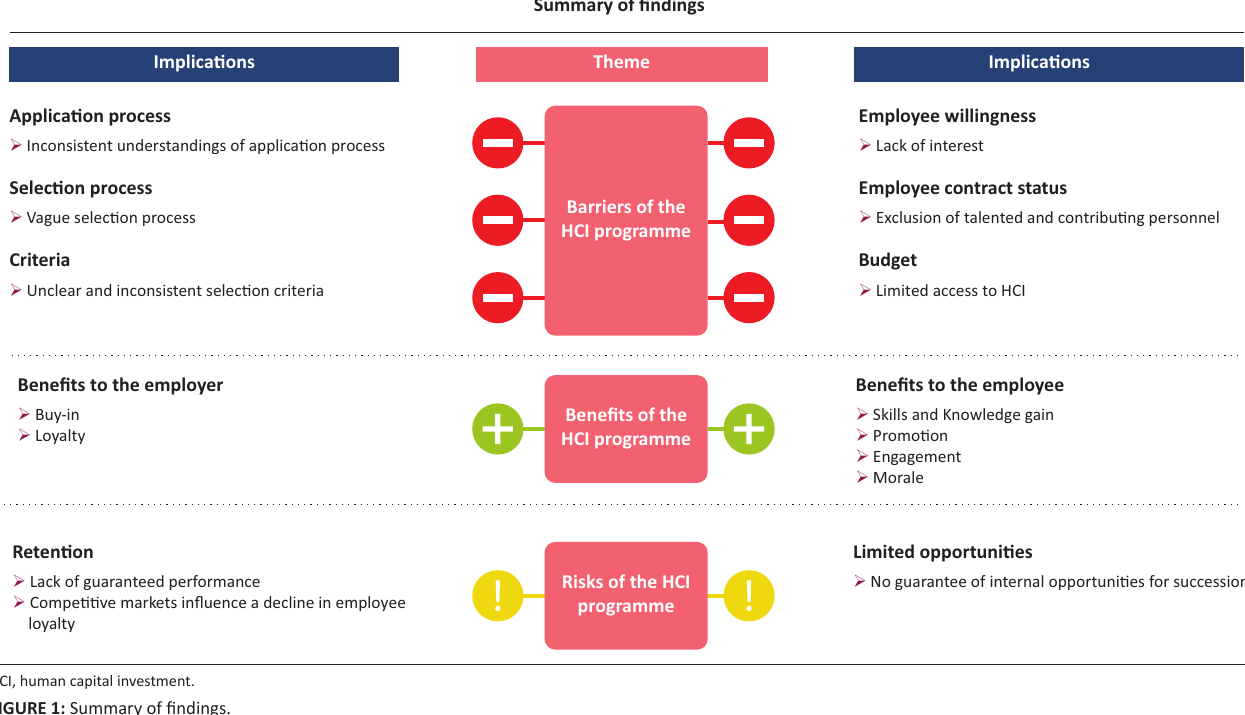
FIGURE 1: Summary of